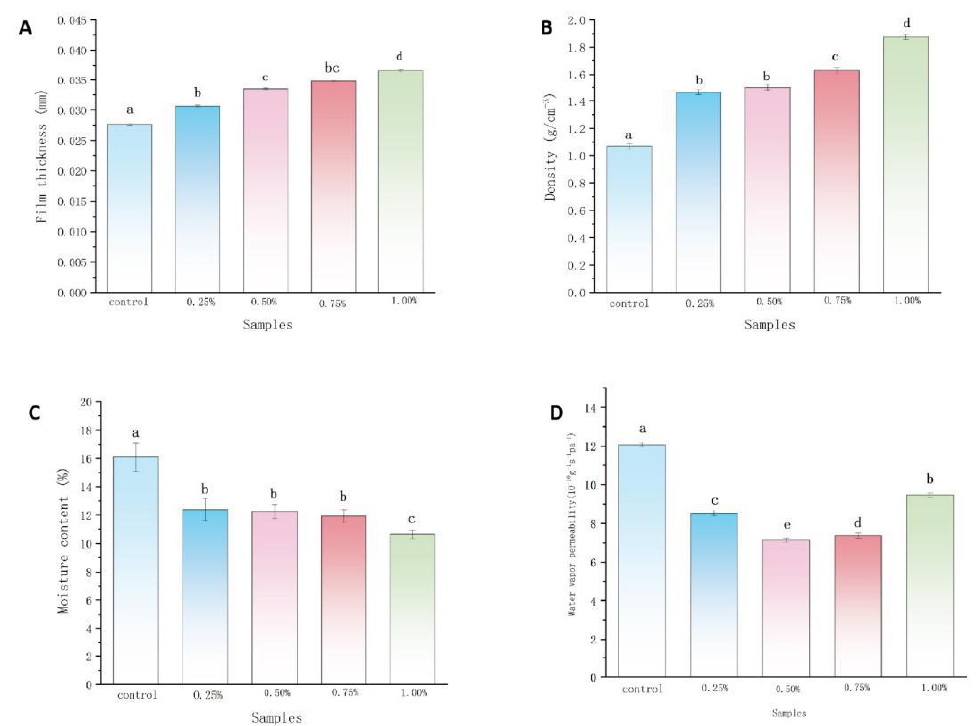
Figure 1. Thickness ( A ), density ( B ), moisture content ( C ) and water vapor permeability (WVP) ( D ) of chitosan films without and with different contents of magnolol. Notes: 0%, magnolol-chitosan film without magnolol. 0.25%, magnolol-chitosan film with 0.25% of magnolol. 0.50%, magnolol-chitosan film with 0.50% of magnolol. 0.75%, magnolol-chitosan film with 0.75% of magnolol. 1.00%, magnolol-chitosan film with 1.00% of magnolol.